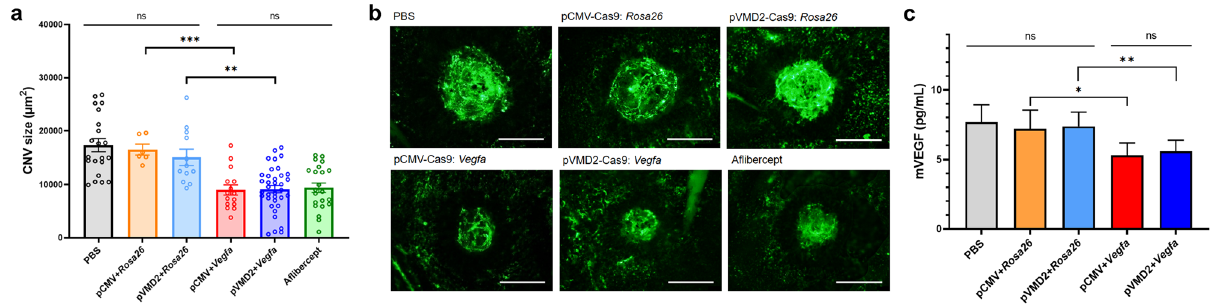
Figure 5. RPE-specific Vegfa ablation efficiently regresses choroidal neovascularization. ( a , b ) When evaluating the therapeutic effect of pVMD2-SpCas9/ pCMV-SpCas9 and mouse Vegfa -targeting gRNA through subretinal injection in laser-induced CNV mice model, pVMD2-SpCas9 and Vegfa -targeting gRNA significantly regressed CNV compared to negative controls and was comparable to pCMV-SpCas9 and Vegfa -targeting gRNA and aflibercept. [Scale bar = 200 µm ( b )]; ( c ) The amount of mouse VEGF protein in vitreous was significantly decreased compared to controls in both Cas9 and Vegfa -targeting gRNA